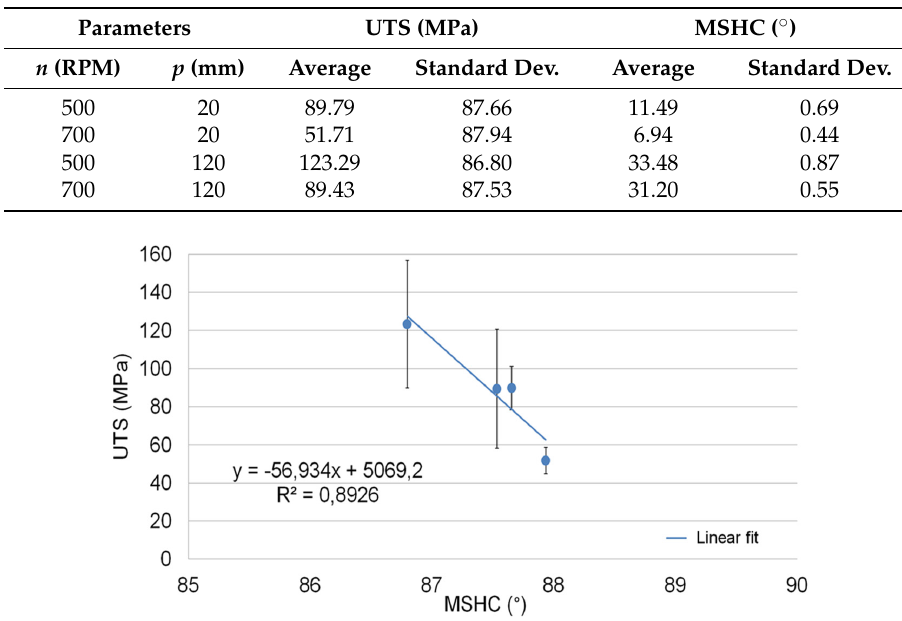
Figure 17. Linear trend of UTS vs. MSHC and error bands.